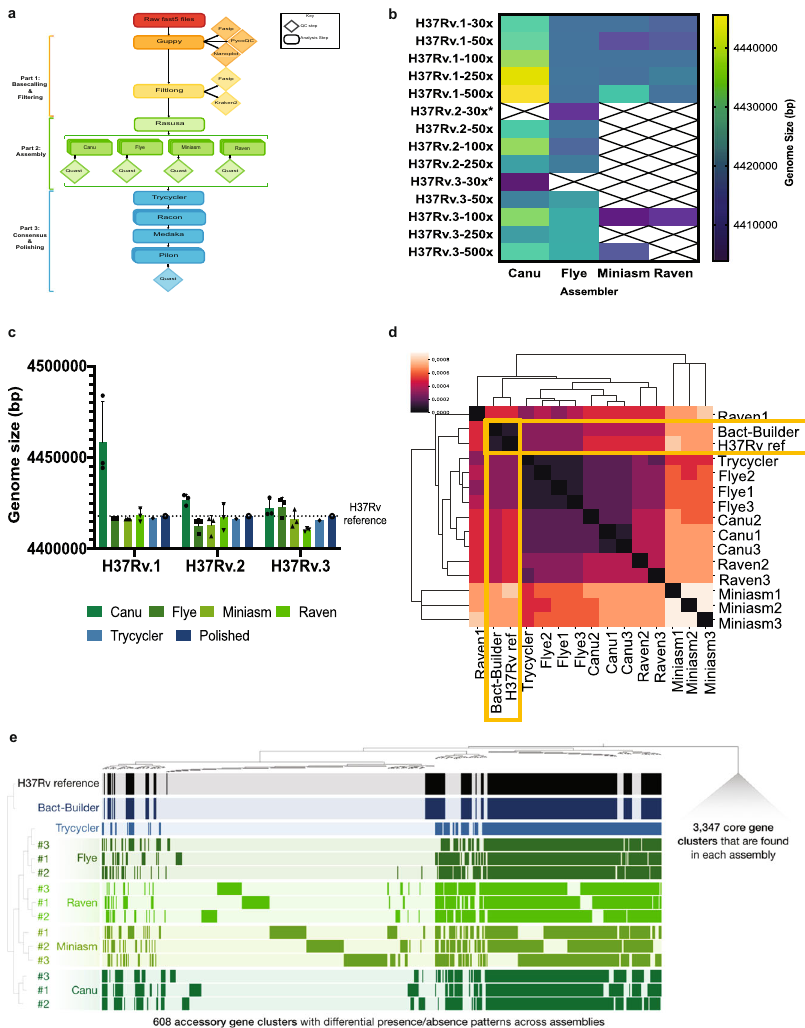
Fig. 1 | Developing Bact-Builder. a Pipeline overview. Bact-Builder takes raw fast5 sequencing data, fi les, assembles, generates a consensus, and polishes bac- terialgenomes. b Heatmapcomparison of genome sizes of four denovo long read assemblers from laboratory stocks of H37Rv sequenced in triplicate (H37Rv.1-3). The sequence coverage sampled for each analysis is shown in each row on the Y axis. Boxes marked by an X indicate that the assemblies did not pass the Trycycler stage because they could not be reconciled with the other assemblies. * Indicates that3outof4assemblerscouldnotbereconciled,necessitatingthatTrycyclerwas run with only 1 assembler. c Three replicates of laboratory stocks of H37Rv